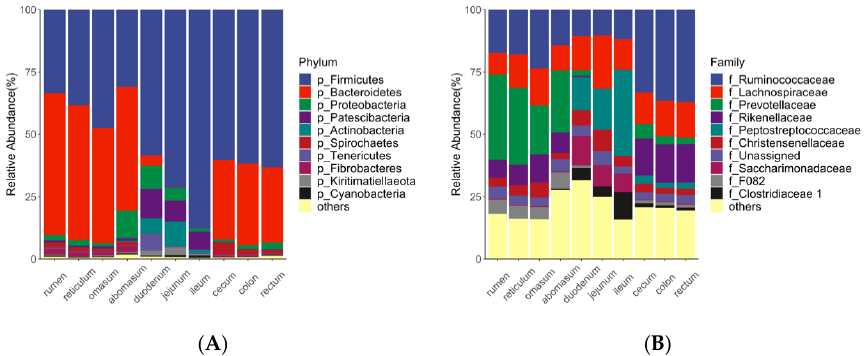
Figure 2. The taxonomic profile of microbial communities at the phylum ( A ) and family level ( B ) across different regions of gastrointestinal tract (GIT). Taxa with relative abundance ranked below 10 were grouped in others.